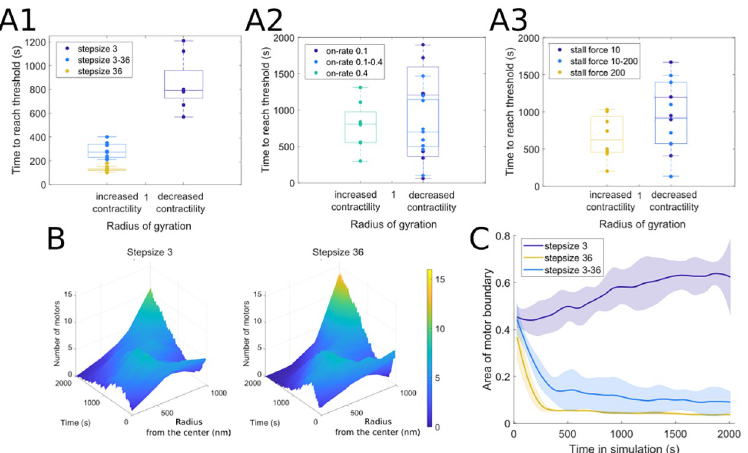
Fig 9. In two motor population simulations, motors with large step sizes, low binding rates, and low stall forces dominate actomyosin organization dynamics. (A) Timing to reach threshold in contractility ( ± 10% in left panel, ± 5% in center and right panels), showing that (A1) large step size, (A2) low binding rates, and (A3) low stall forces dominate the dynamics of contractility. Compare to Figs 5, 6 and 7. (B) Localization of motors and (C) Motor spread in simulations with motors with 3 nm and 36 nm step sizes, further demonstrating that the large step size dictates the dynamics of the ensemble independently of the dynamics contributed by the motor protein with a smaller step size. Unless otherwise indicated above, the parameter values used for both motors are d step = 6 nm, k head,bind = 0.2/s, F s = 100 pN, range heads = 15–30 (see Table 1). Solid lines indicate the average and shaded areas indicate the standard deviation over 10 independent stochastic